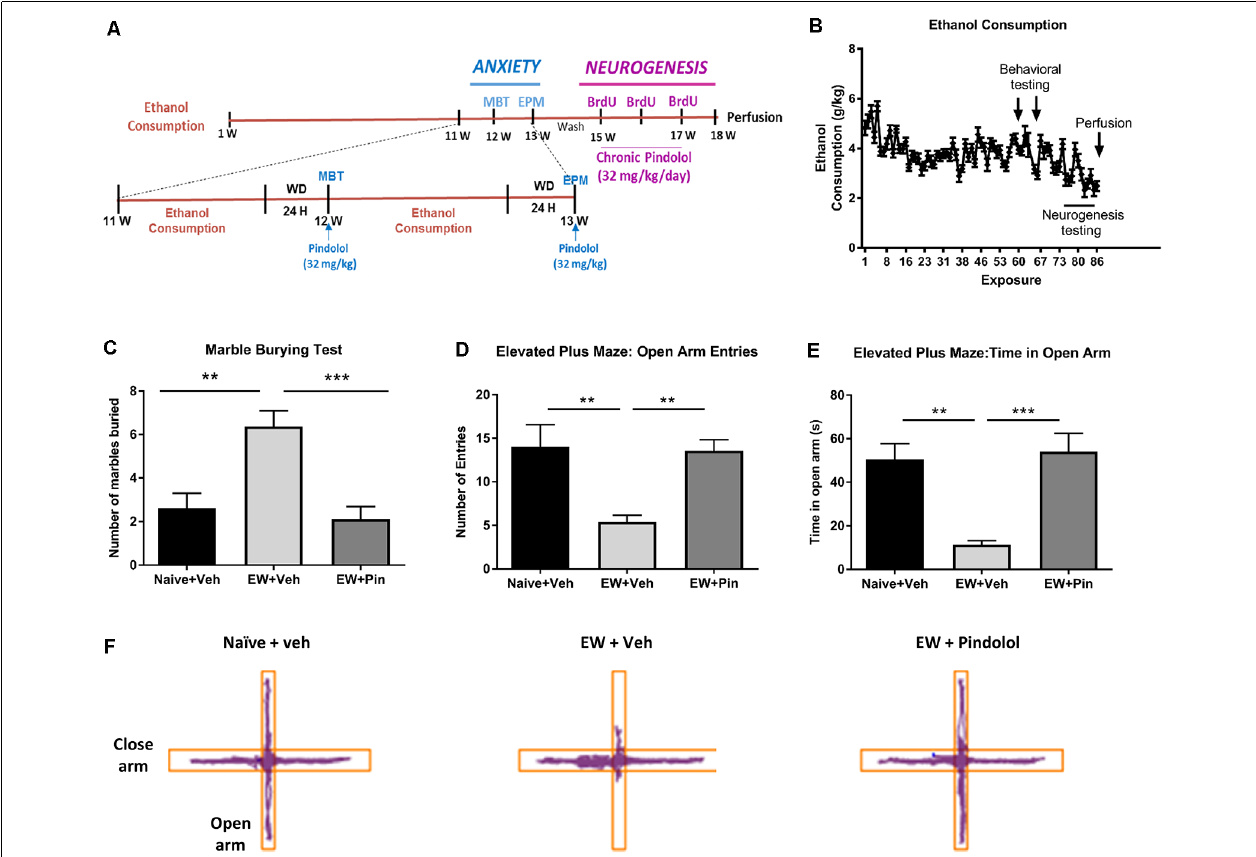
FIGURE 1 | Effects of long-term alcohol consumption levels and pindolol on anxiety-related behavior. Experimental design of the effects of long-term alcohol and pindolol on withdrawal-induced anxiety-like behavior and neurogenesis. Voluntary alcohol intake was allowed in mice for 18 weeks using the Drinking-in-the-Dark (DID) Paradigm paradigm. Anxiety tests; MBP and EPM were carried out in weeks 12 and 13 respectively, where the animals had a 2 h access to alcohol during the weekdays followed by a 24 h withdrawal period before examination of the effects of an acute injection of pindolol (32 mg/kg). These animals were allowed a 2-week drug washout period where they continued to have access to alcohol following which the animals received three acute injections of BrdU (150 mg/kg) in 3 weeks and 2-week chronic injections of pindolol before sacrificing them for the examination of neurogenesis (A) . Mean ± SEM alcohol intake (g/kg) for mice in the DID paradigm over 18 weeks or 90 drinking sessions. Anxiety-related tests were carried out at 24 h withdrawal in week 12 (MBT) and week 13 (EPM) while the neurogenesis testing was carried out in weeks 15–18 (B) . For the anxiety tests, alcohol-naive mice were treated with vehicle (Naïve+Veh) and alcohol-withdrawn mice with either vehicle (EW+Veh) or pindolol (EW+Pin; C–F ). MBT shows an increased number of marbles buried by alcohol-withdrawn mice (anxiety-like behavior) which behaved similarly to the naïve controls post pindolol pre-treatment (C) . In the EPM, alcohol-withdrawn mice show a reduced number of entries in the open arm of the EPM (anxiety-like behavior) which is altered by pindolol pre-treatment (D) . Also, alcohol-withdrawn mice spend less time in open arm of the EPM (anxiety-like behavior) which is reduced by pindolol pre-treatment ( E ). Pindolol (32 mg/kg, i.p.) was administered 30 min prior to a 20 min (MBT) or 5 min (EPM) testing period. Data are presented as mean ± SEM; n = 5–6 mice/group. ∗∗ p < 0.01; ∗∗∗ p < 0.001 (one-way ANOVA followed by Bonferroni’s post hoc analysis). Representative tracks of the ambulation of the animals in the open arm vs. close arm of the EPM (F)